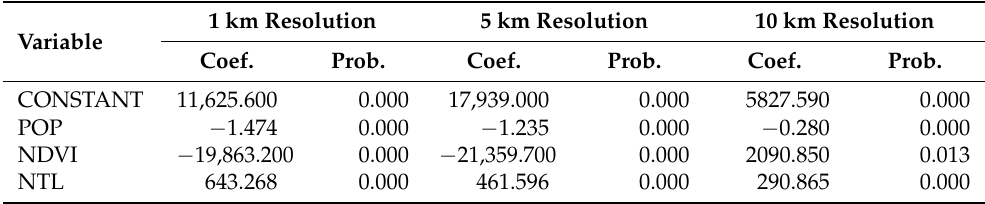
Table 3. Estimated results for the OLSM.